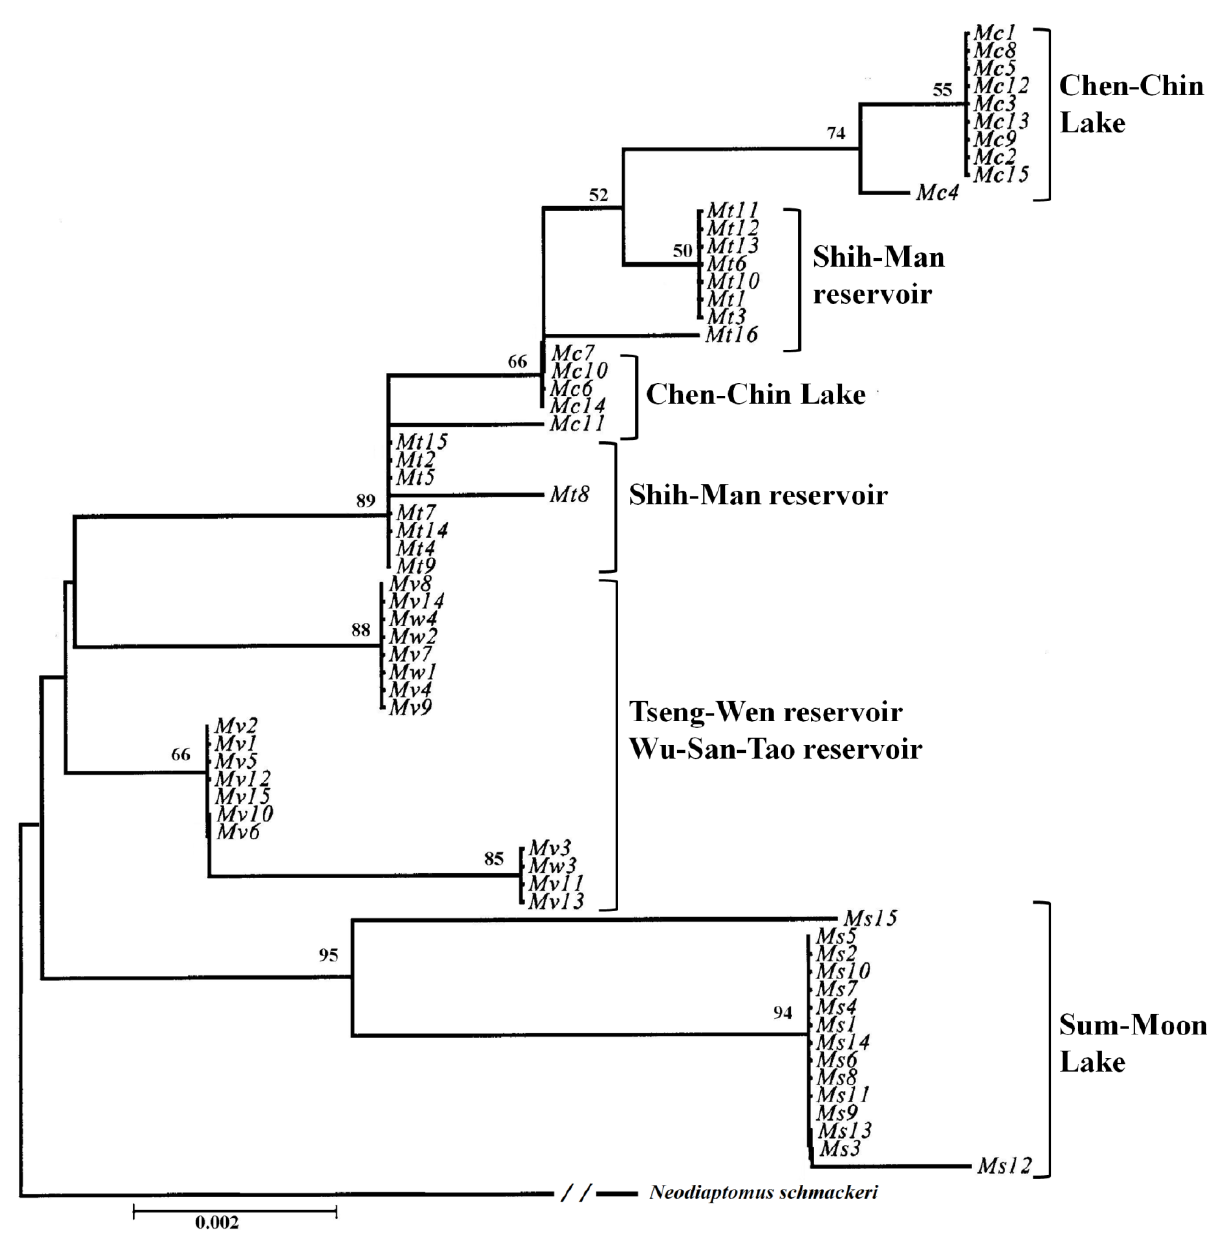
Figure 4. The geophylogenetic tree of Mongolodiaptomus birulai by the neighbor-joining method [23] based on the Kimura 2-parameter process with 1,000